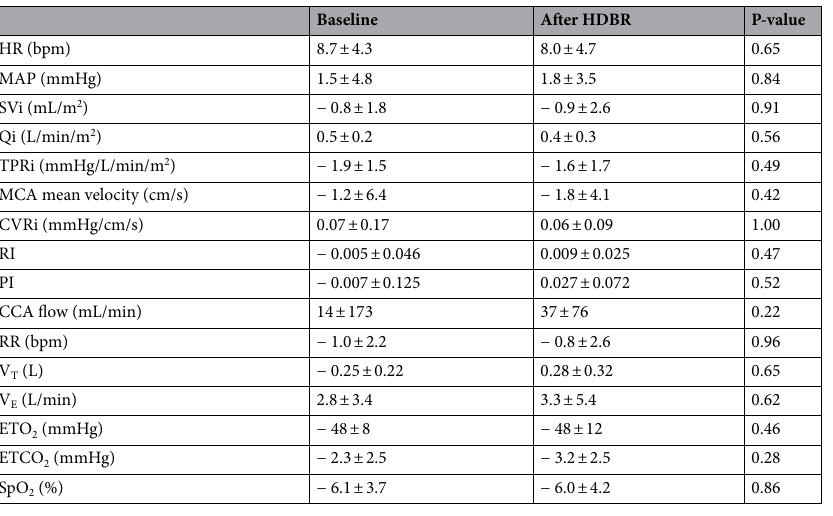
Table 3. Change in cardiorespiratory and cerebrovascular responses to hypoxia before and after HDBR. HR heart rate, MAP mean arterial pressure, SVi stroke volume index, Qi cardiac index, TPRi total